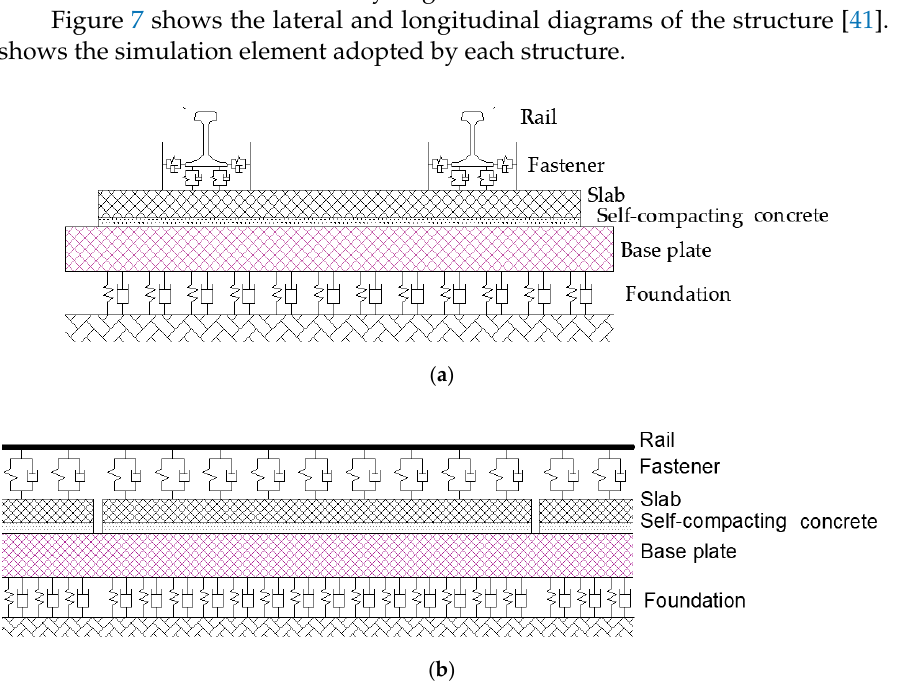
Table 2. Main structure parameters.